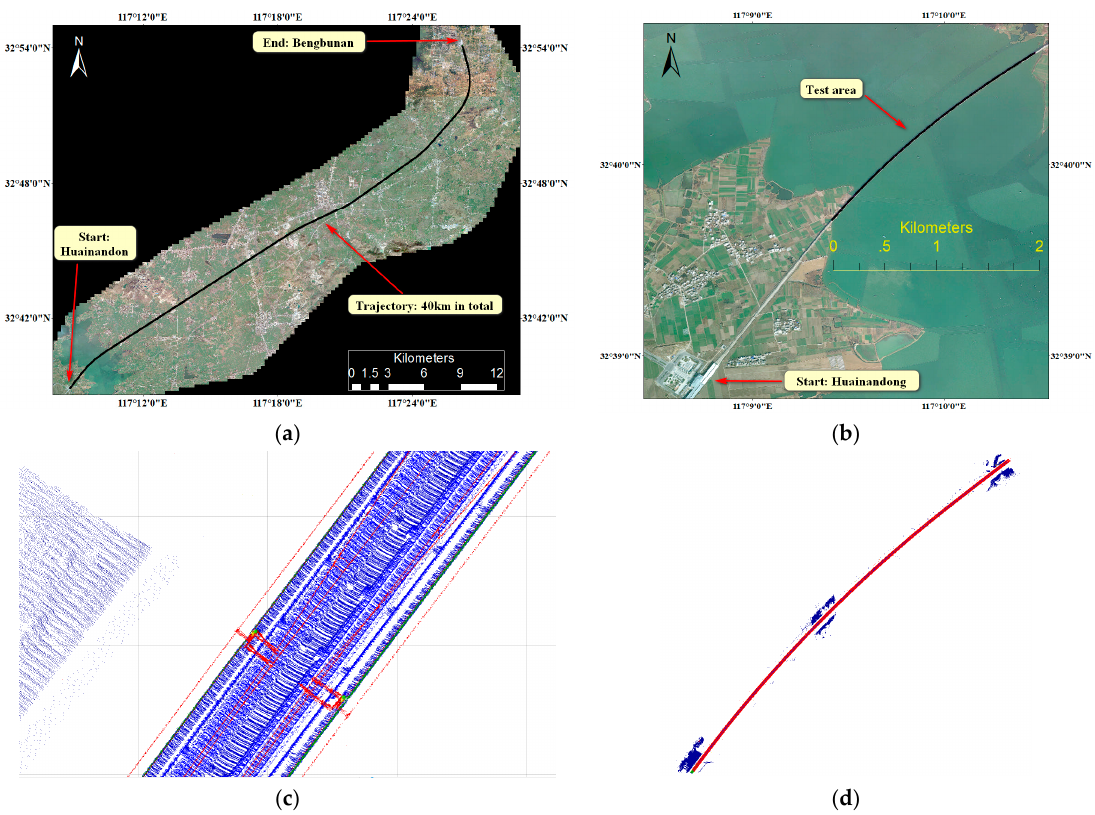
Figure 9. ( a ) Trajectory of experiment; ( b ) Rails extraction experiment section; ( c ) Portion of test data near start point, top view; ( d ) LiDAR scan results of rail extraction test area. near start point, top view; ( d ) LiDAR scan results of rail extraction test